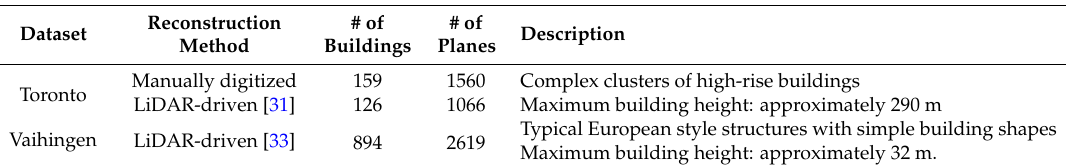
Table 1. Characteristics of reference building models.